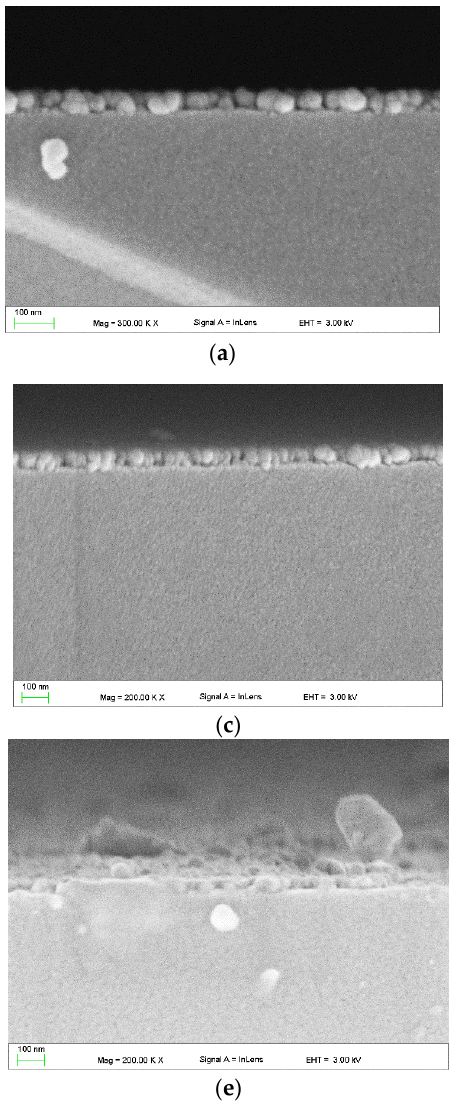
Figure 10. Cross ‐ section SEM images of the ZnO films, respectively: ZnO ‐ 2 ( a ), ZnO ‐ 14 ( b ), ZnO ‐ 30 Figure 10. Cross-section SEM images of the ZnO films, respectively: ZnO-2 ( a ), ZnO-14 ( b ), ZnO-30 ( c ), ZnO ‐ 41 ( d ), and ZnO ‐ 64 ( e ). ( c ), ZnO-41 ( d ), and ZnO-64 ( e ).